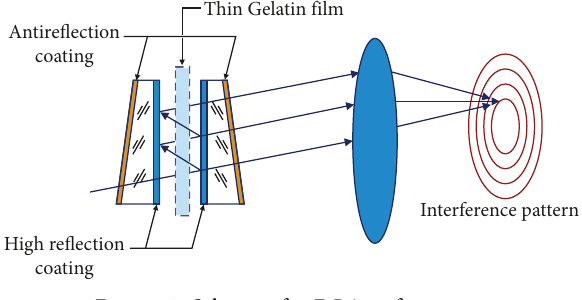
Figure 1: Scheme of a F - P interferometer.